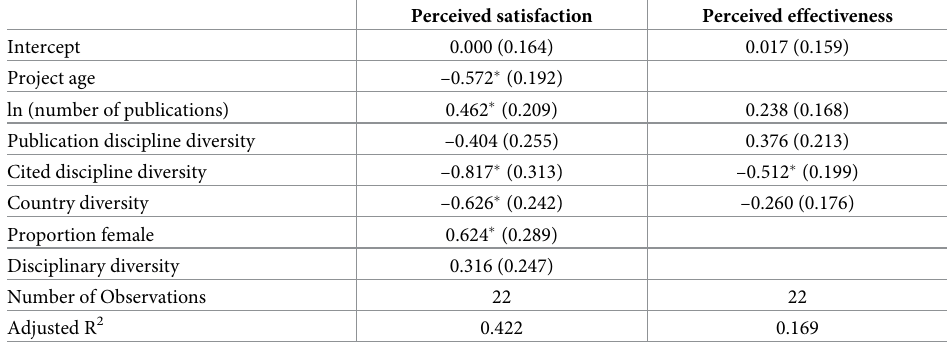
Table 4. Predictors of satisfaction and perceived group effectiveness.